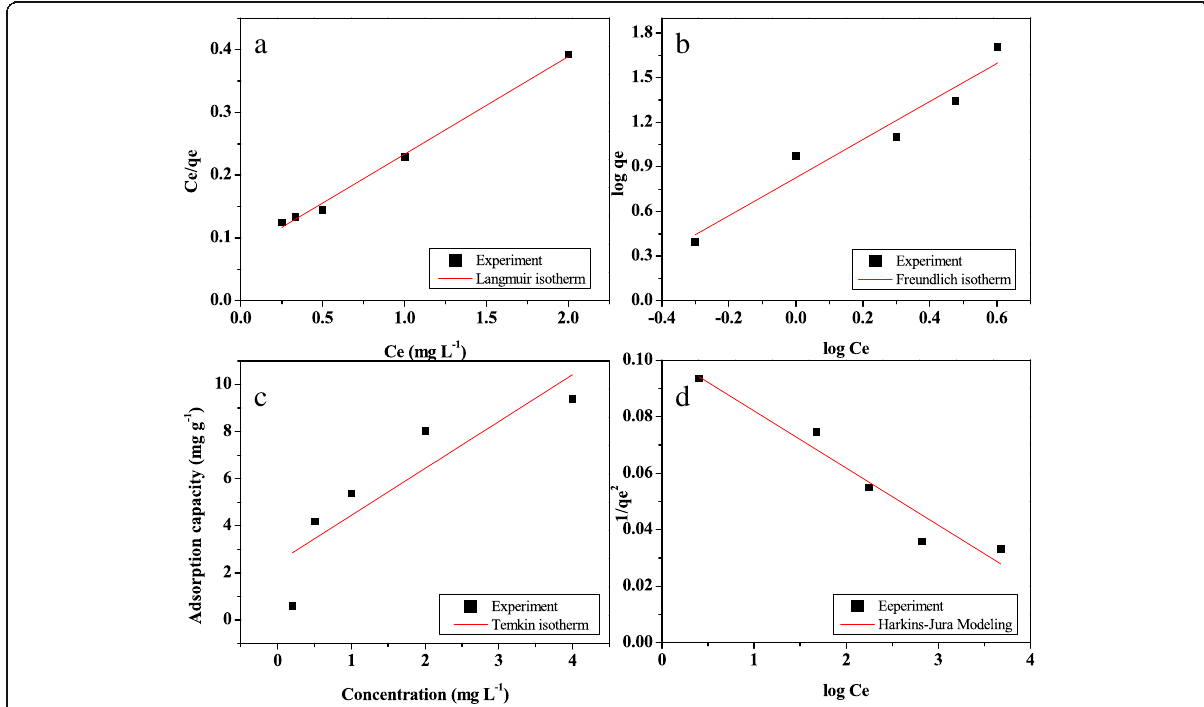
Fig. 5 Isotherms of arsenic adsorption with phosphorene ( a ) Langmuir, ( b ) Freundlich, ( c ) Temkin and ( d ) Harkins-Jura